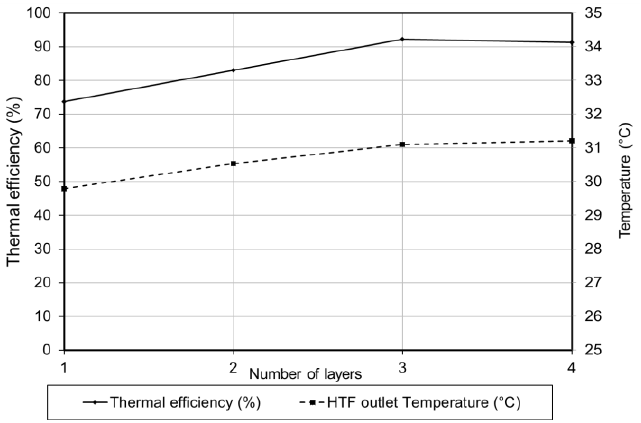
Figure 12. Effects of number of layers on the HTF outlet temperature and thermal performance of 30 mL/min HTF flow rate and 15 W power rate.